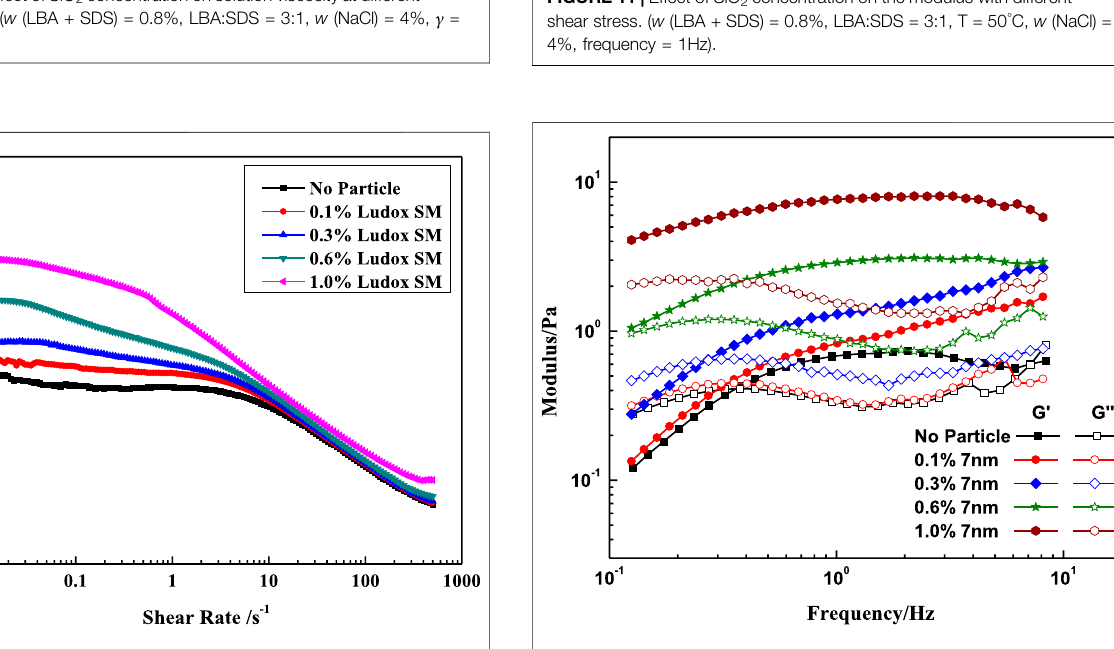
FIGURE 10 | Effect of SiO 2 concentration on solution viscosity at different shear rates. ( w (LBA + SDS) (cid:2) 0.8%, LBA:SDS (cid:2) 3:1, T (cid:2) 50 ° C, w (NaCl) (cid:2) 4%).